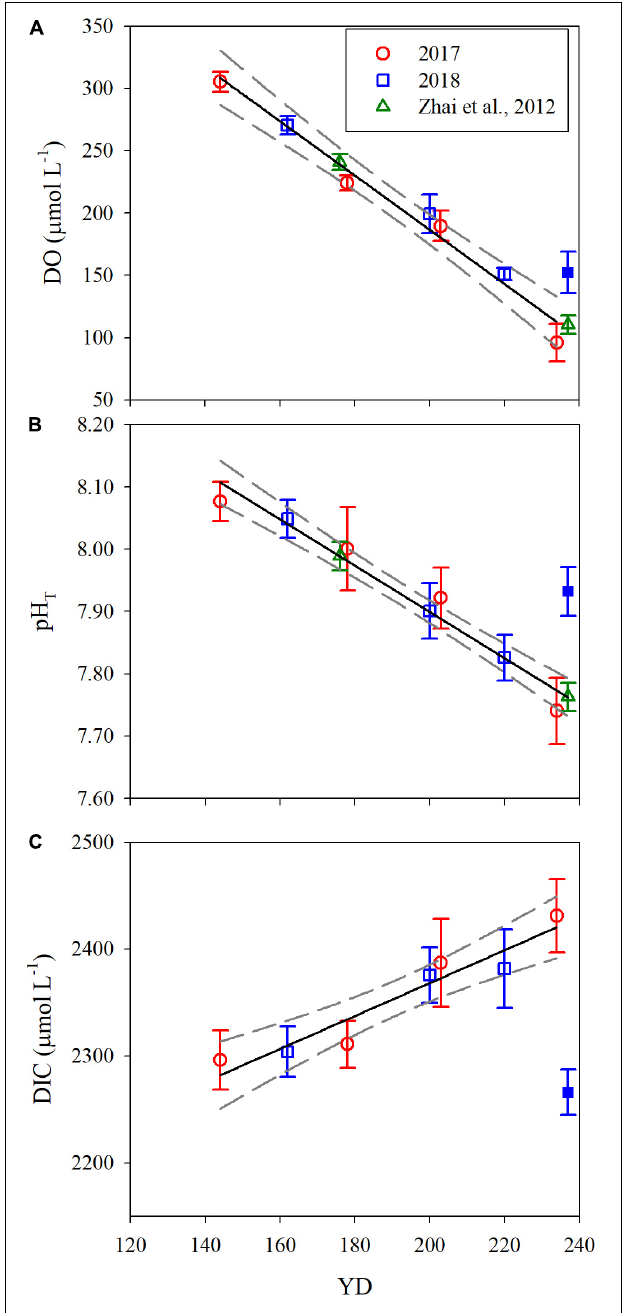
FIGURE 4 | Temporal evolution of the mean DO (A) , pH T (B) , and DIC (C) in bottom water along the sampling transect. YD stands for day of the year. Error bars are 1 standard deviation. The solid and dashed lines are the linear fit to the data and 95% confidence interval, respectively. The solid blue points on YD 237 were excluded for data